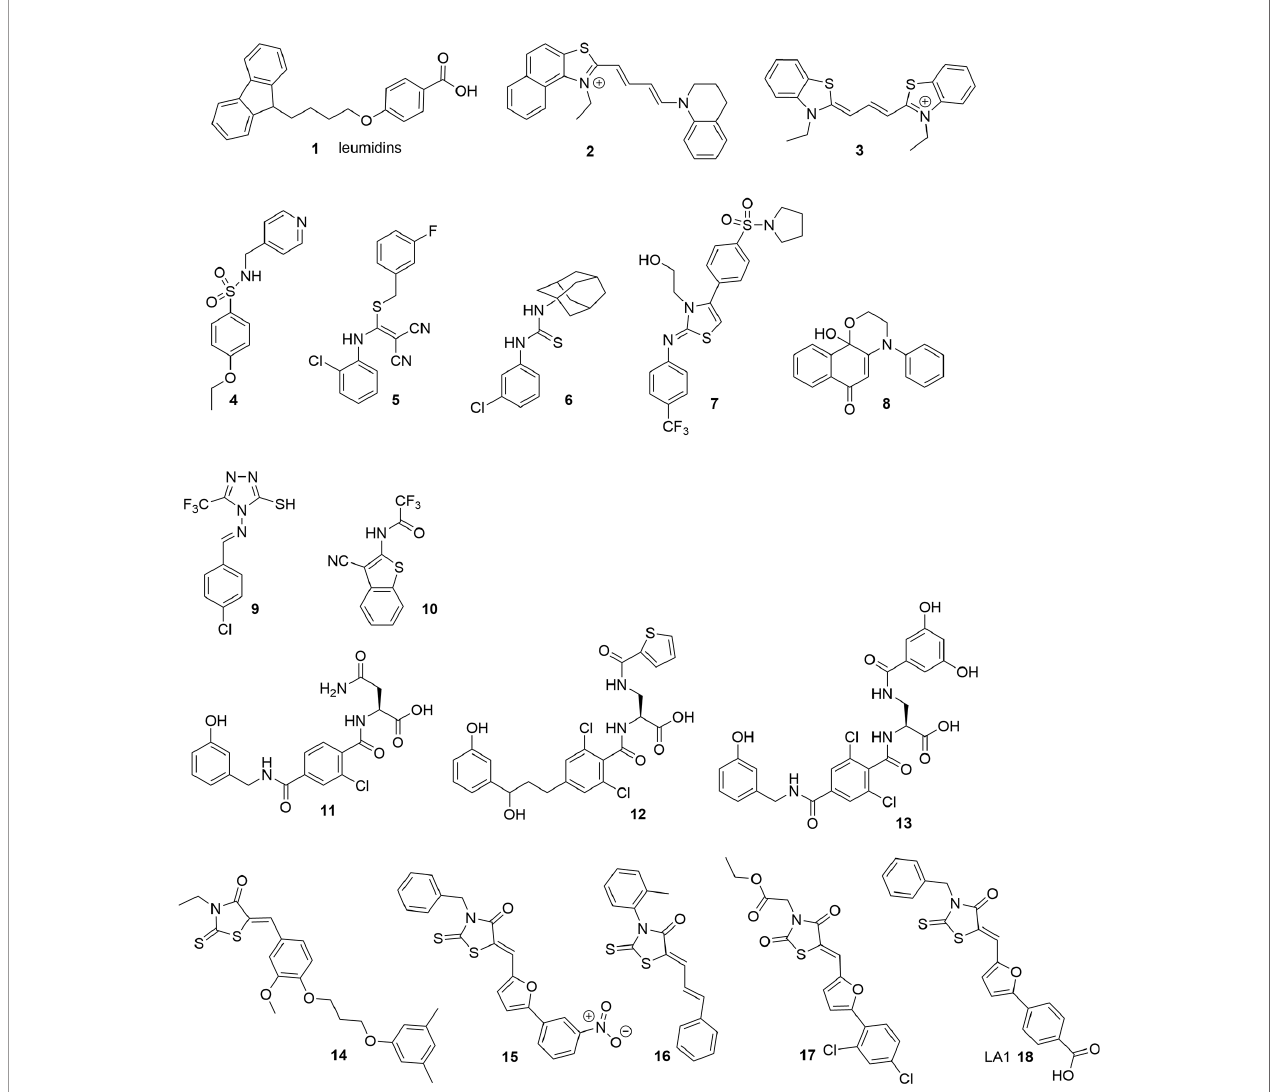
FIGURE 6 | Small molecules developed as possible CR3